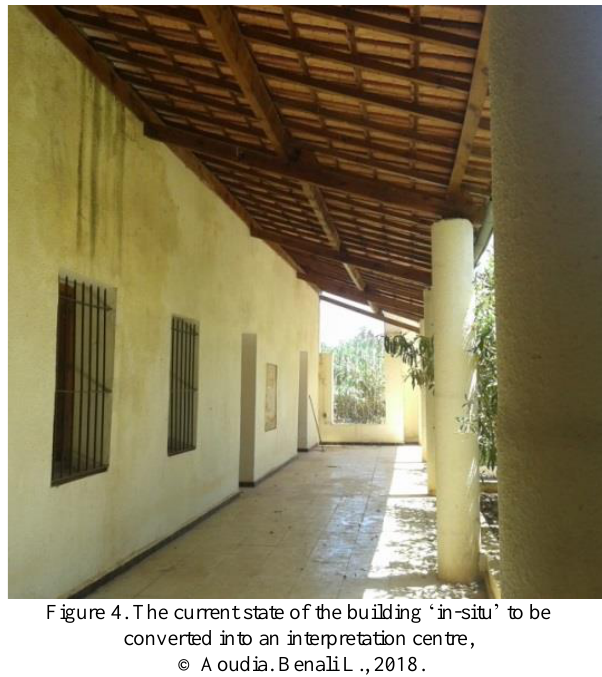
Figure 4. The current state of the building ‘in-situ’ to be converted into an interpretation centre, © Aoudia. Benali L.,